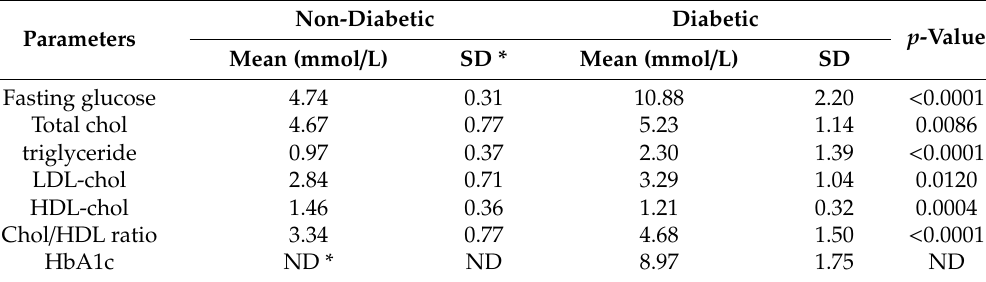
Table 4. Non-diabetic and diabetic female patient’s biomarkers of